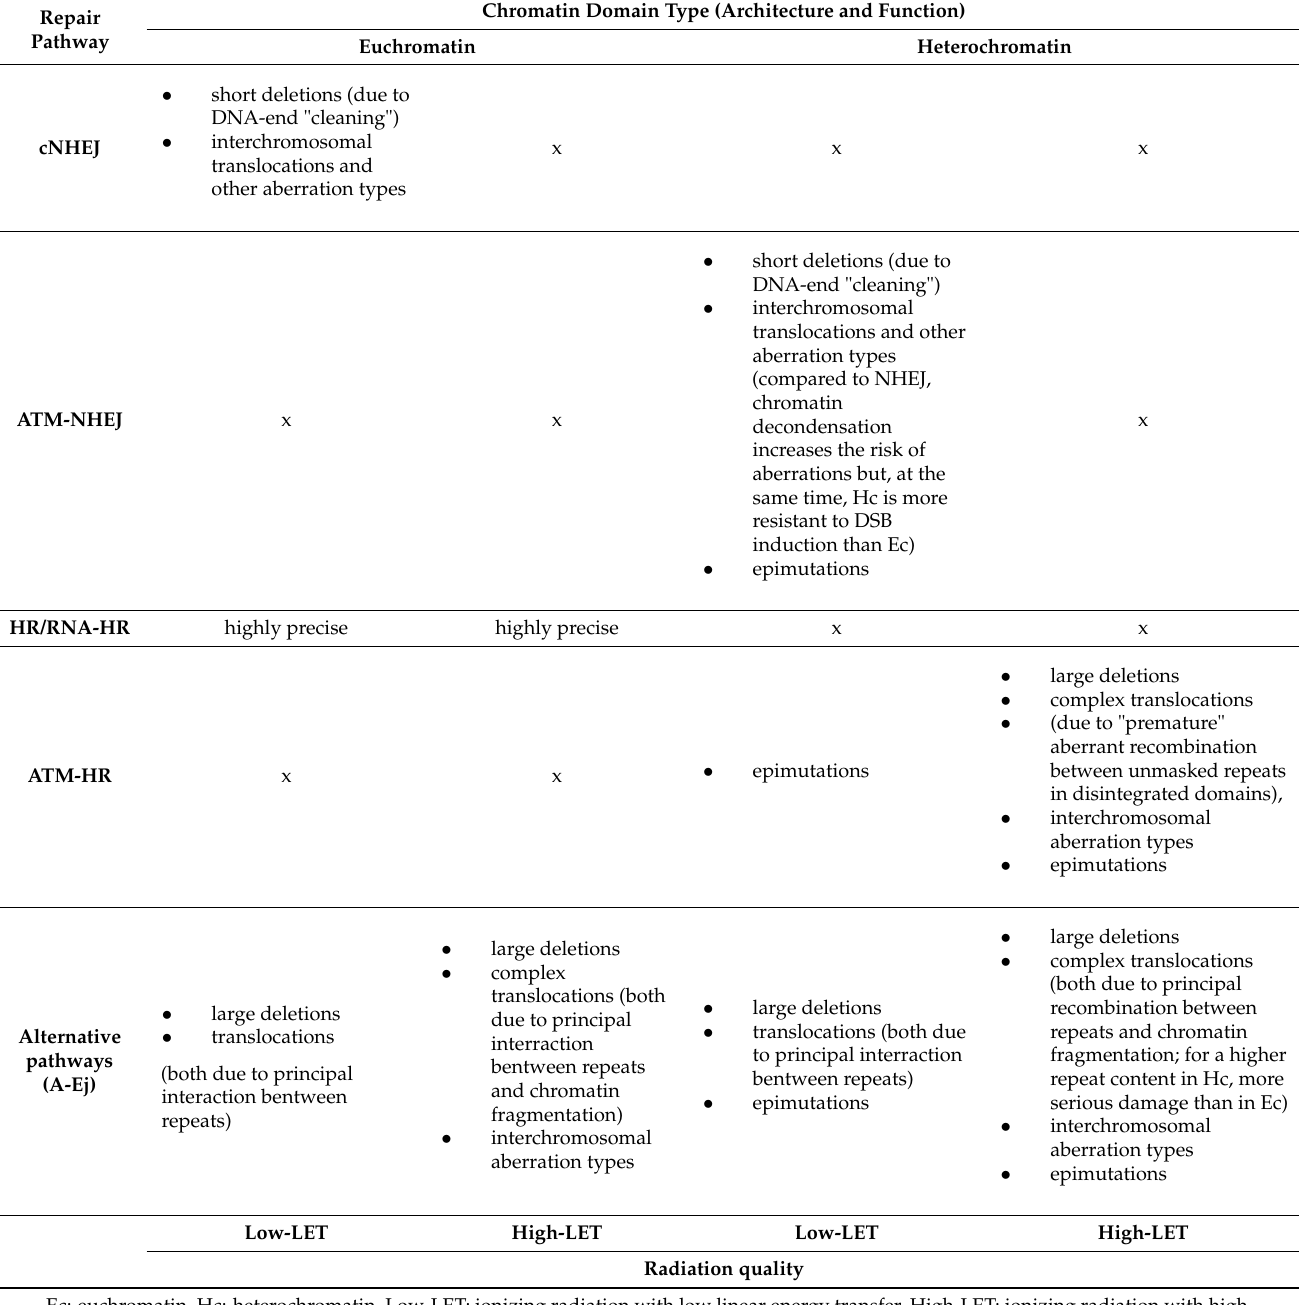
Table 1. Relationship between the physical characteristics of the incident radiation, the chromatin architecture at the DSB damage site, the utilized repair mechanism (pathway) and the types of potentially generated chromosomal aberrations or